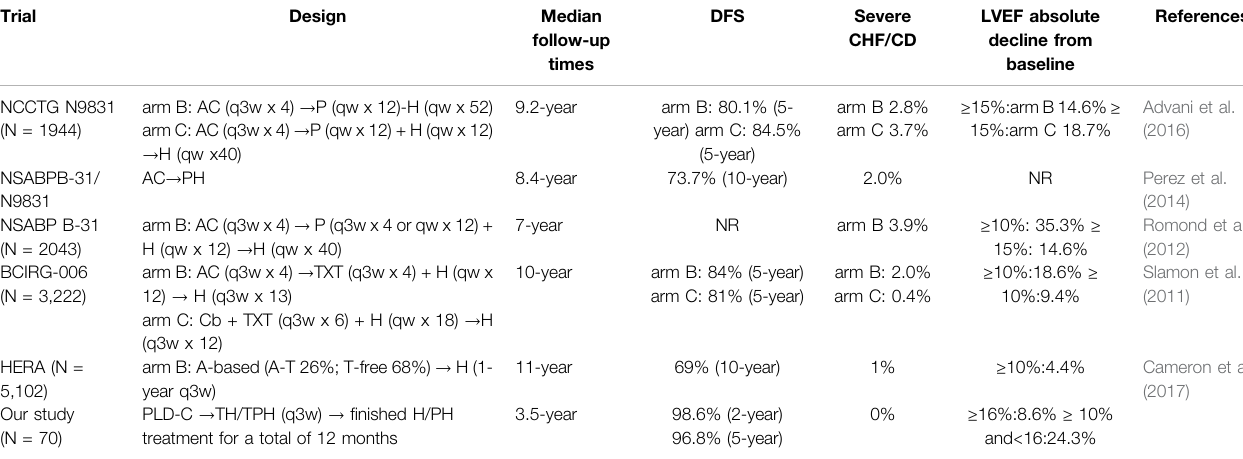
TABLE 3 | Summary of the cardiac safety and ef fi cacy results of our study compared with other pivotal adjuvant trastuzumab trials. Trial Design Median